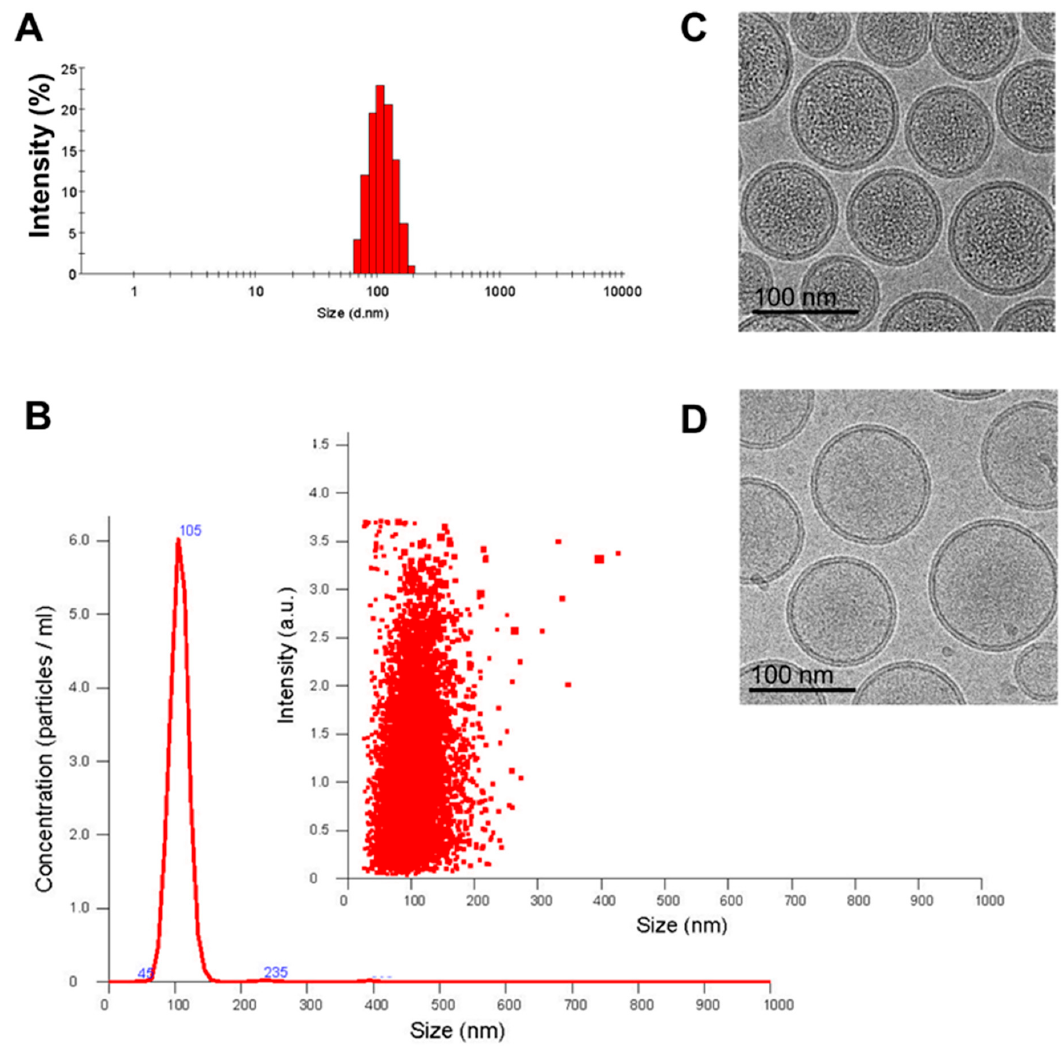
Figure 1. Characterization of Lipo-IRI (irinotecan) formulation. The size of Lipo-IRI was estimated using ( A ) dynamic light scattering (DLS) and ( B ) nanoparticle tracking analysis (NTA). The size distribution and particle concentration were calculated as intensity and particles/ml, respectively. The cryo-transmission electron microscopy (TEM) imaging was performed on a drug-loaded 1,2- Distearoyl-sn-glycero-phosphocholine (DSPC)/Cholesterol formulation either ( C ) with or ( D ) without irinotecan (IRI). (10 μ mol/mL phospholipid; scale bar represents 100 nm).